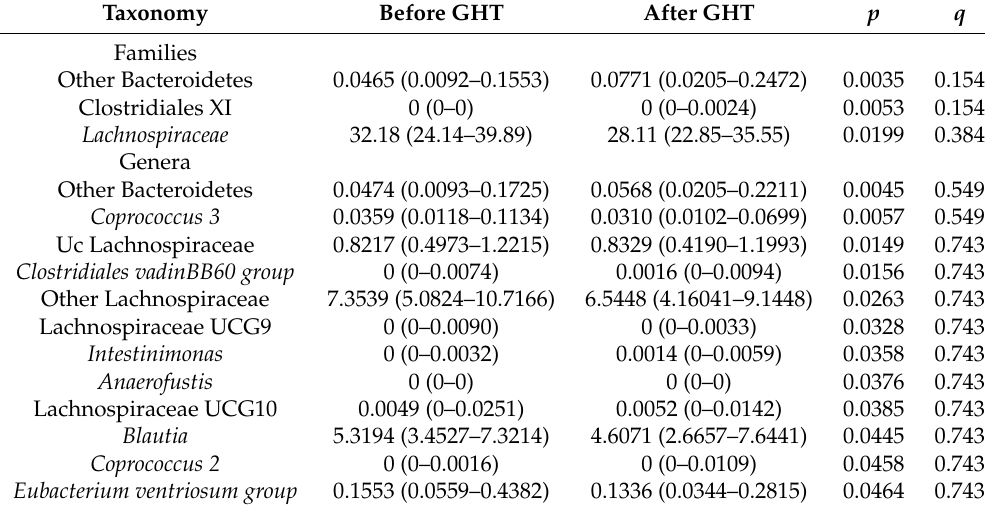
Table 2. Taxa with altered abundance before and after GHT.